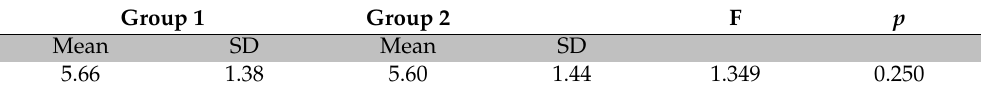
Table 3. Impact of between factor (group) on task 1 (PE). Effect of between factor (group) on task 1 (PE). Group 1